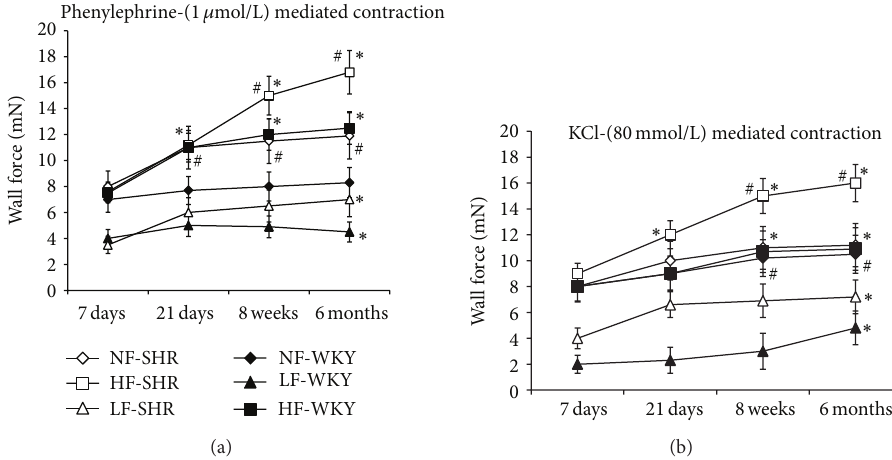
Figure 3: Phenylephrine- (1 𝜇 mol/L, (a)) and KCl (80 mmol/L, (b)) evoked contraction measured in mesenteric resistance arteries isolated from WKY rats and SHRs submitted to low flow (LF), high flow (HF), or normal flow (NF) for 1, 3, 8, or 24 weeks. Values represent mean ± SEM ( 𝑛 = 12 rats per group). ∗ 𝑃 < 0.01 , HF or LF versus NF arteries. # 𝑃 < 0.05 , SHRs versus WKY rats, within equivalent arteries (NF, LF, or HF).